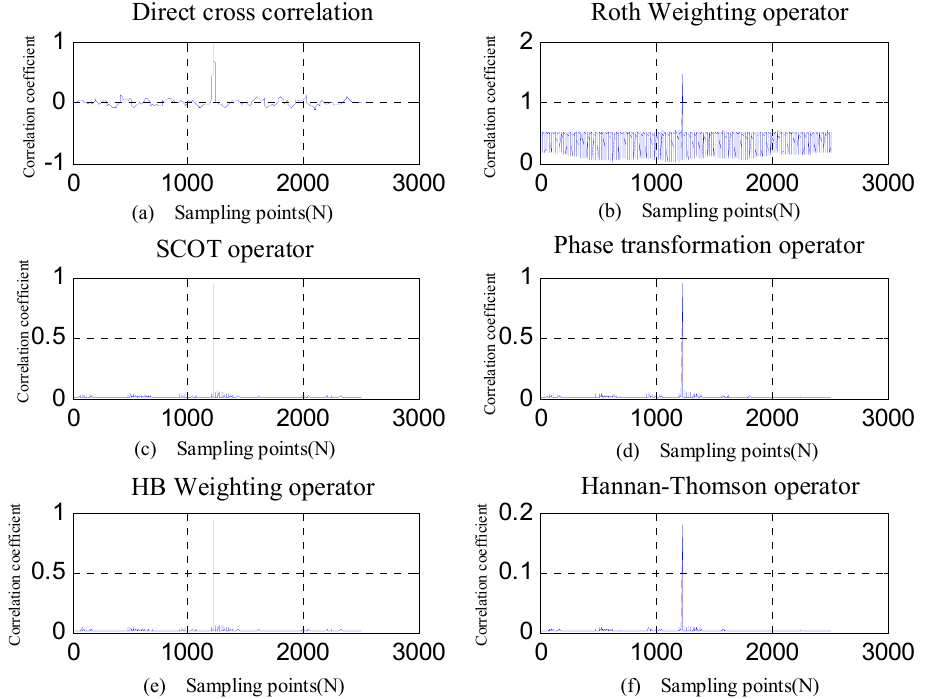
Figure 22. Time-difference measurement results based on generalized correlation methods: ( a ) direct cross-correlation, ( b ) Roth weighting operator, ( c ) smoothed correlation transform (SCOT) operator, ( d ) phase transformation (PHAT) operator, ( e ) HB weighting operator, and ( f ) Hannan–Thomson operator.